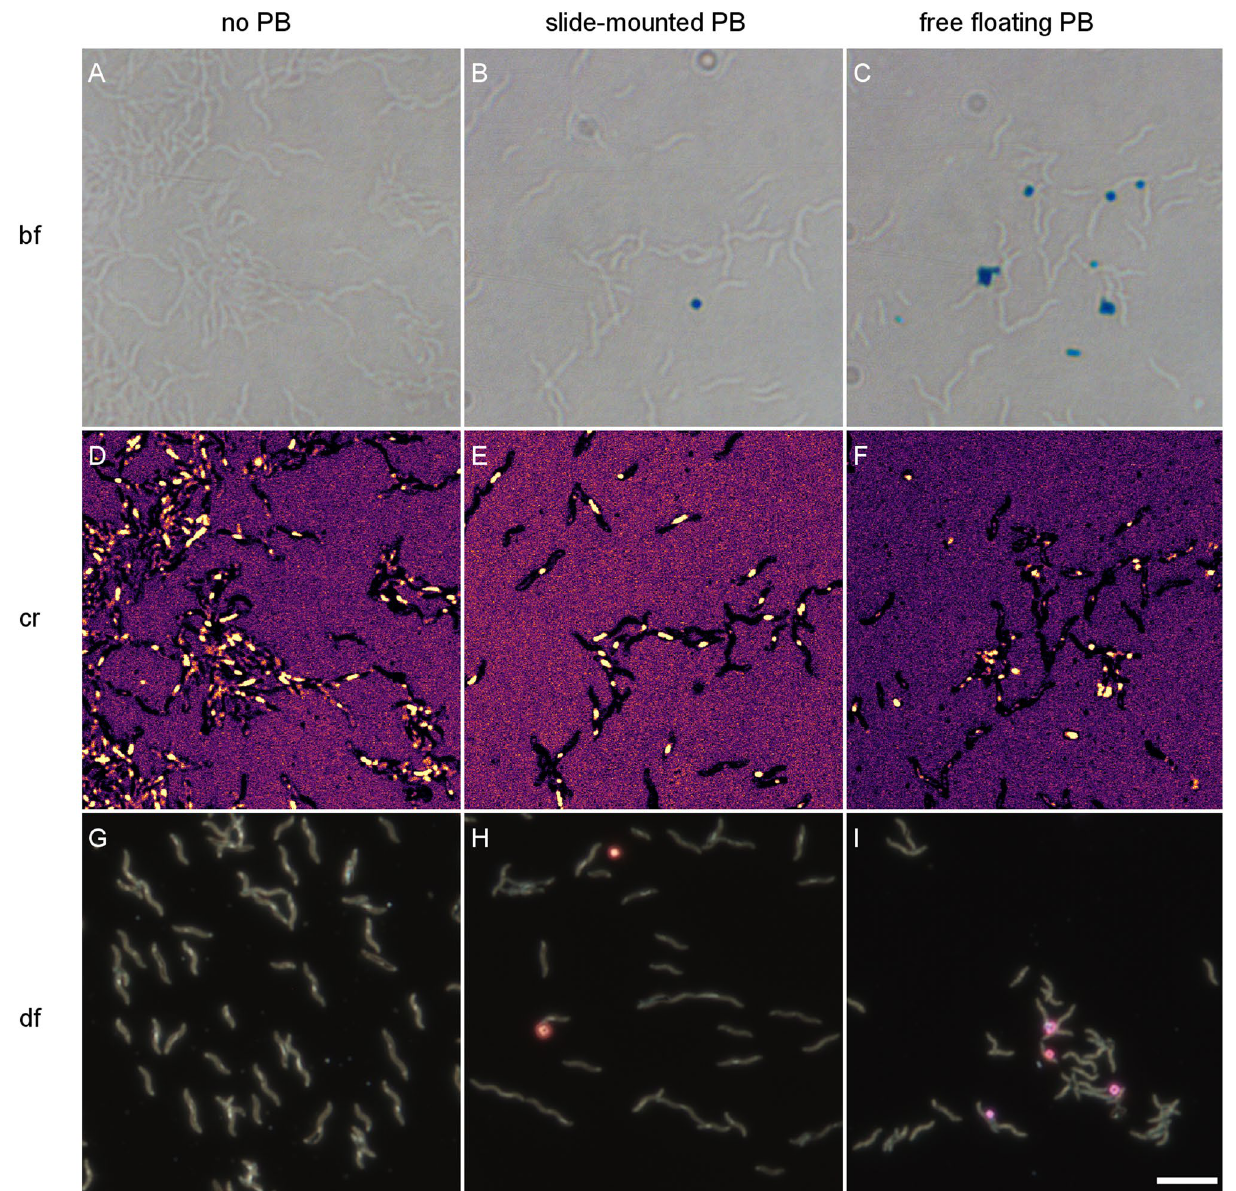
Figure 5. Prussian Blue (PB) method does not stain intracellular magnetosome chains in Magnetospirillum magnetotacticum. ( A , B , C ) transmitted-light bright-field (bf) images of A: untreated cells, B: slide-mounted cells treated with PB protocol, C: free floating cells treated with PB and placed on microscopy slide afterwards. Some of the suspension was placed on a copper grid for further analysis with transmission electron microscopy (Figs. 6 and 7). PB reaction products can be clearly recognized by their blue color ( B , C ), but are definitely extracellular in the slide-mounted preparation ( B ), with a clear distance to the cell bodies. In the free-floating cell preparation ( C ), the PB reaction products appear closer to the cell, which likely represents a centrifugation artifact. ( D , E , F ) Same field of view as in A, B, C, respectively, but imaged with confocal reflectance (cr) at 488 nm, featuring intracellular magnetosome chains as bright reflective objects. Depending on their crystal size and degree of crystallinity, PB reaction products may or may not appear under confocal reflectance ( E , F ). ( G , H , I ) Enhanced dark field (df) images of the same slides as in D, E, F, respectively, albeit with different field of views. Under dark-field contrast magnetosome chains appear as slender white objects, while PB reaction products appear in their complementary color (orange to pink). As in ( B ), the PB reaction products in ( H ) are clearly extracellular. In particular, all magnetosome chains have the same white color as in the untreated sample ( G ), which independently confirms the lack of PB stainability of intracellular magnetosome chains. Scale bar 5